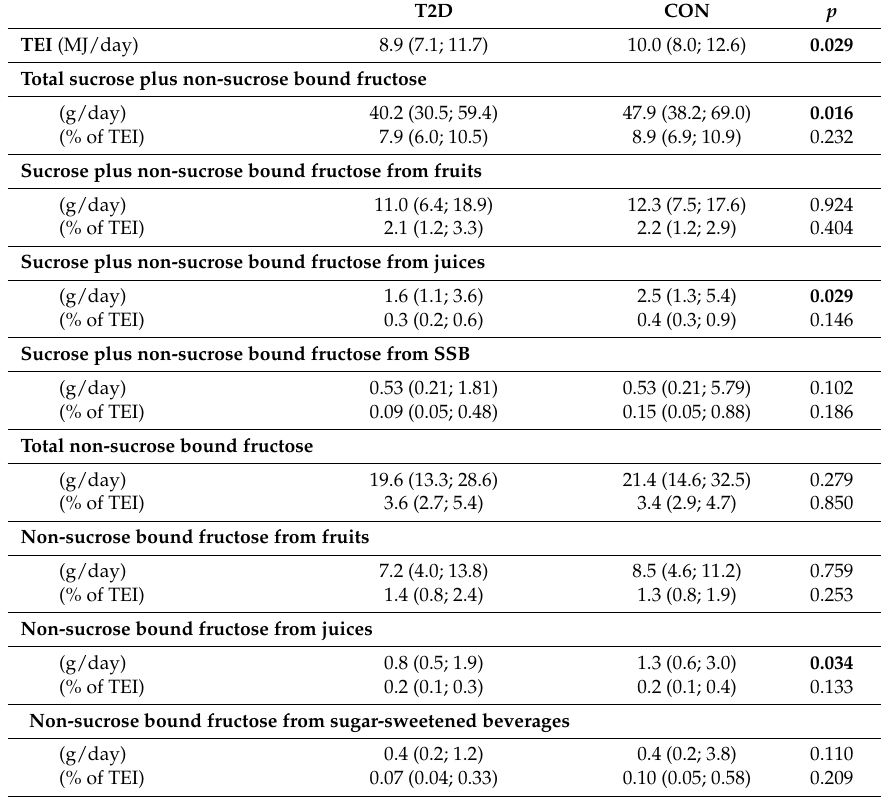
Table 2. Dietary characteristics of patients with type 2 diabetes and individuals without